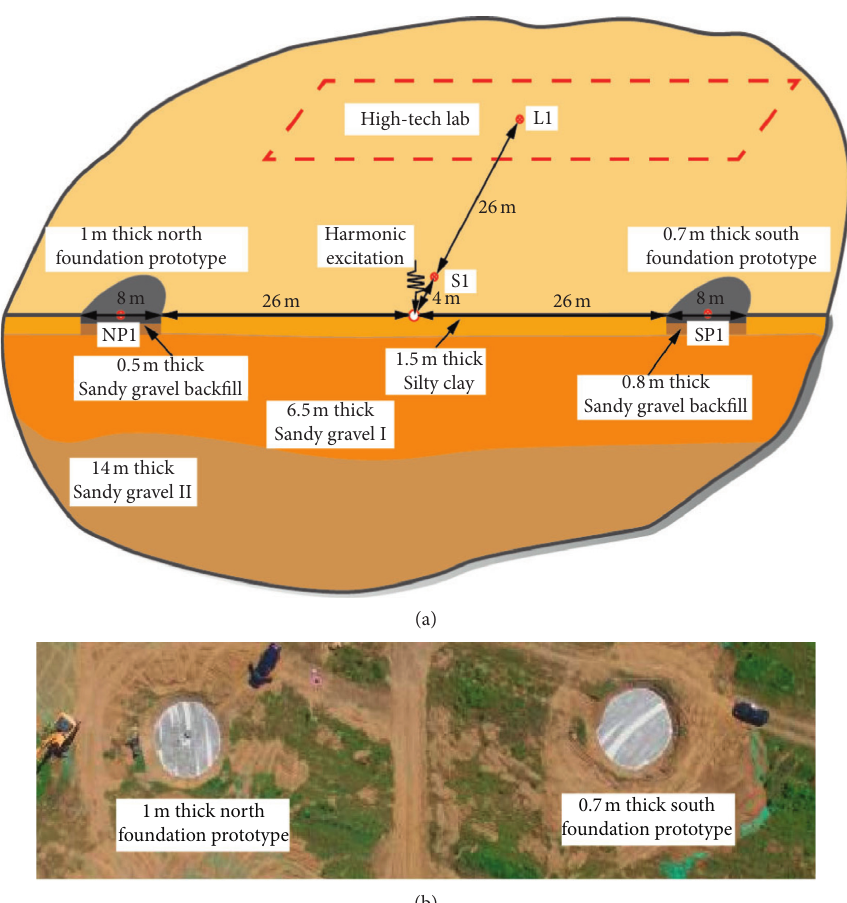
Figure 5: Foundation slab prototypes: (a) sketch of the antivibration foundation prototypes, (b) aerial photo of the foundation prototypes.